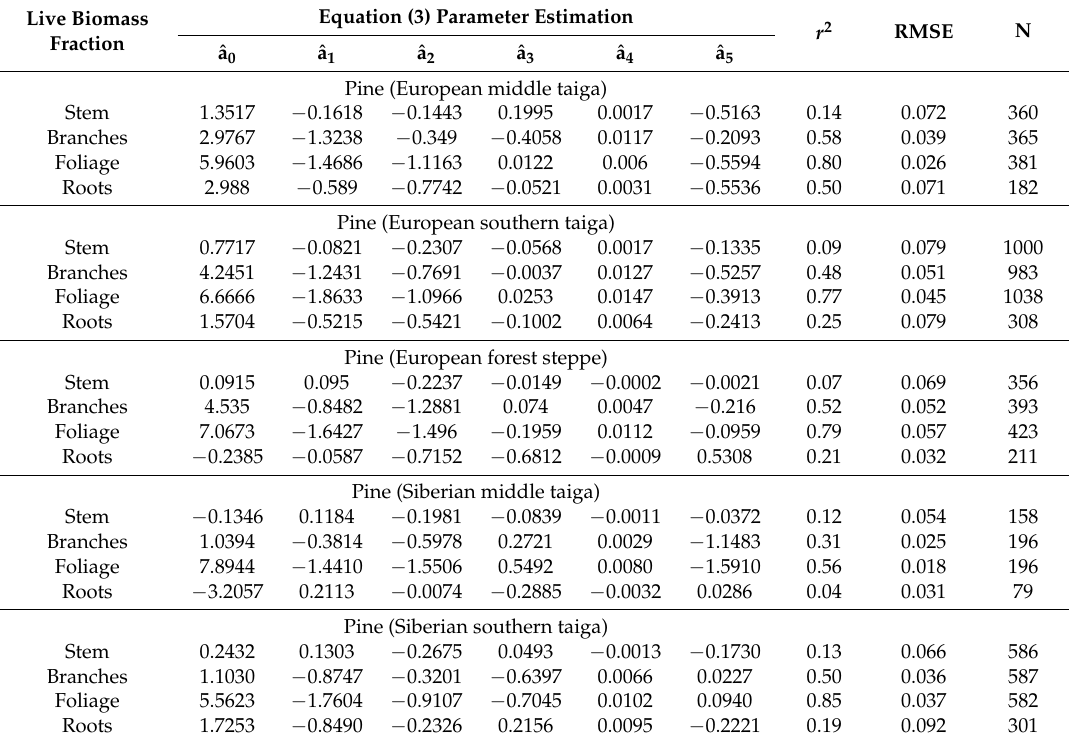
Table A2. Parameters of the forest live biomass from Equation